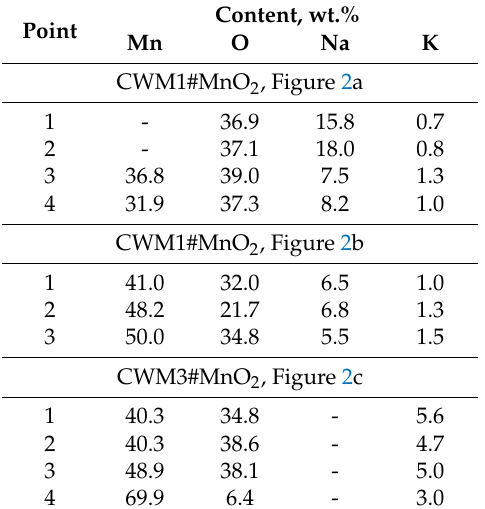
Table 2. Results of hybrid materials’ EDS point analysis.